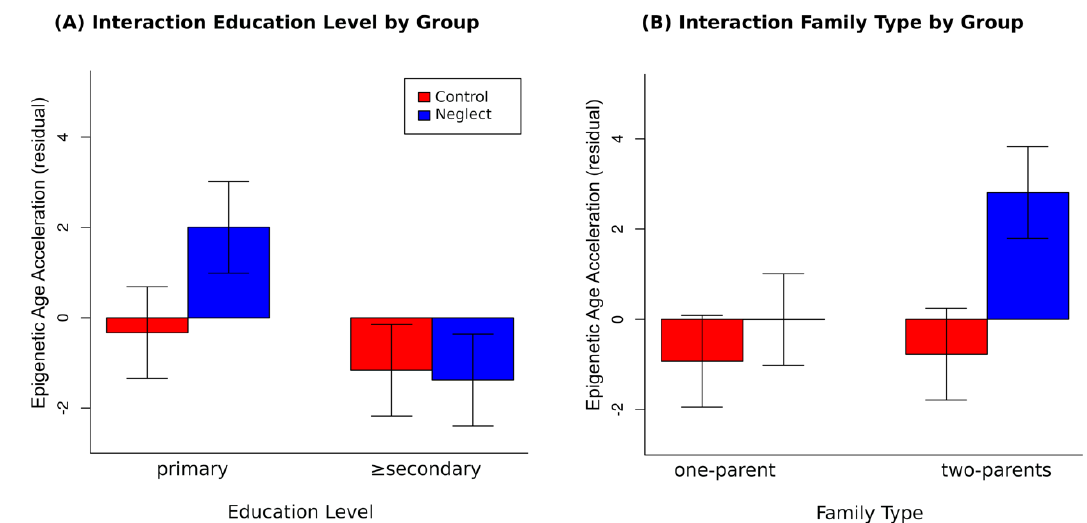
Figure 3. ( A ) Interactive effect of Level of Education and Group showing that EAA increases are obtained for those mothers with primary education in the NG only. In contrast, group differences were not significant at the secondary level. ( B ) Interactive effects of Type of Family and group showing that EAA increases are obtained for those mothers living in two-parent families in the NG only. In contrast, group differences were not significant in one-parent families.